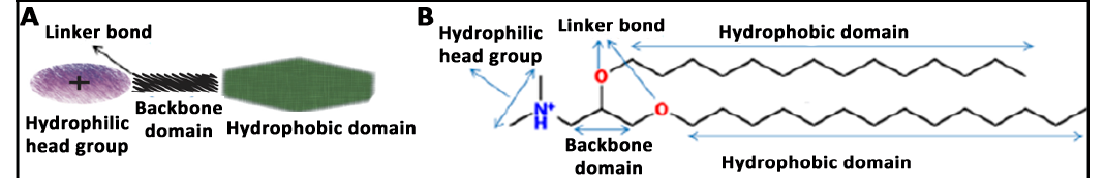
Figure 2. ( A ) General chemical structure of cationic lipids for gene therapy applications with four domains. ( B ) Chemical structure of cationic lipid 2,3-di(tetradecyloxy)propan-1-amine. The